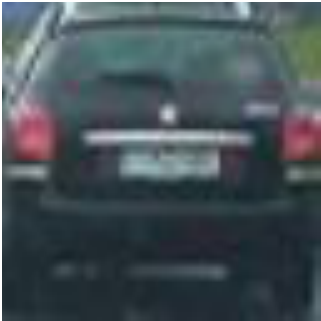
Figure 4. Sample input image from the validation dataset.